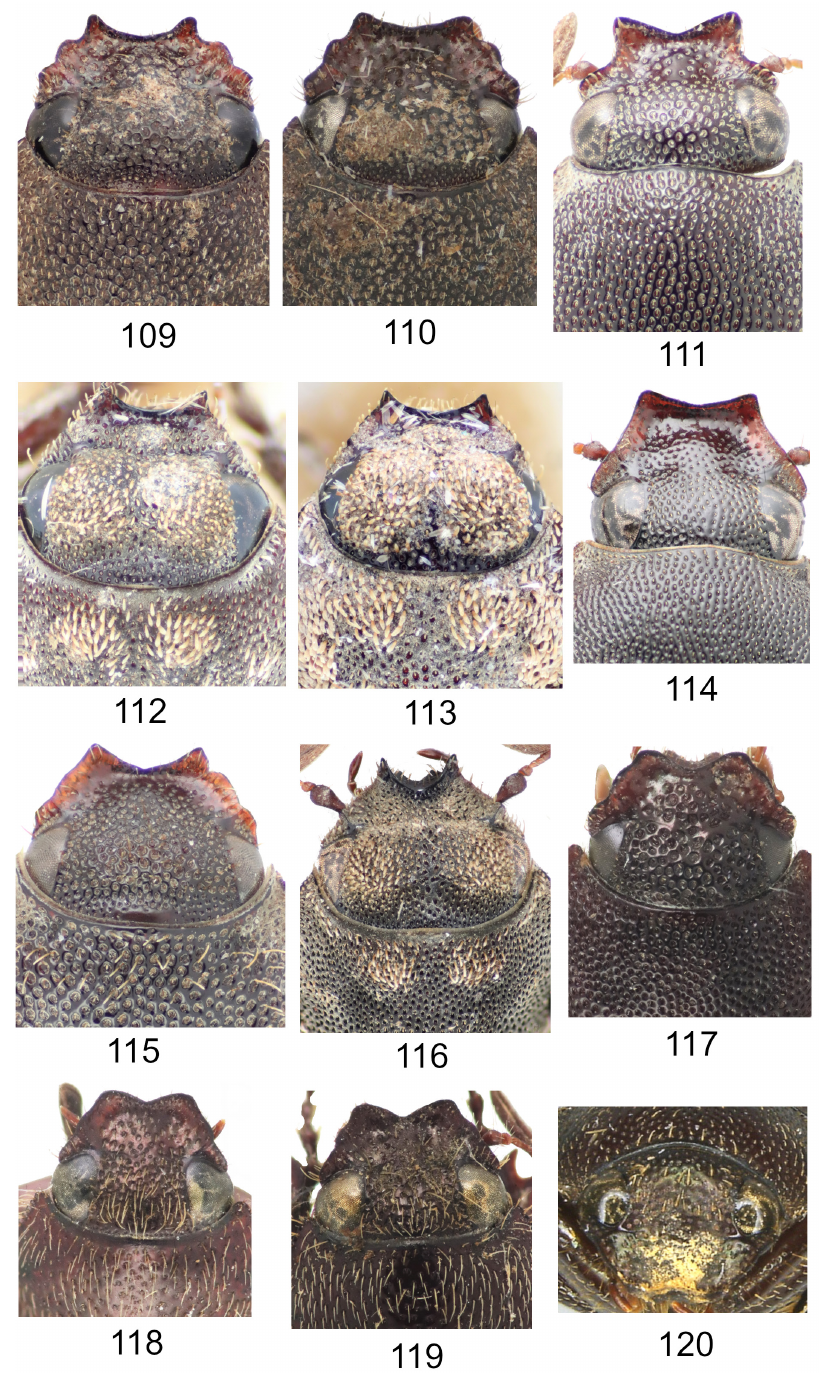
Figs 109–120. Papuan and Wallacean Maechidius Macleay, 1819, head, dorsal (109–119) and frontal (120) views. 109 . M. brocki sp. nov., holotype, ♂ (BMNH). 110 . Same, paratype, ♀ (BMNH). 111 . M. ciliatus sp. nov., holotype, ♂ (IECA). 112 . M. crypticus sp. nov., paratype, ♂ (BMNH). 113 . Same, paratype, ♀ (BMNH). 114 . M. dani sp. nov., holotype, ♂ (IECA). 115 . M. deltouri sp. nov., holotype, ♂ (BMNH). 116 . M. dendrolagus sp. nov., holotype, ♂ (NHMB). 117 . M. fraterculus Moser, 1920, lectotype, ♀ (ZMHB). 118 . M. esau Heller, 1914, lectotype, ♂ (SNSD). 119 . Same, ♂ (lectotype of M. setosus Moser, 1920) (ZMHB). 120 . M. gressitti Frey, 1969, holotype, ♂ (photograph courtesy BPBM) (BPBM). Not to